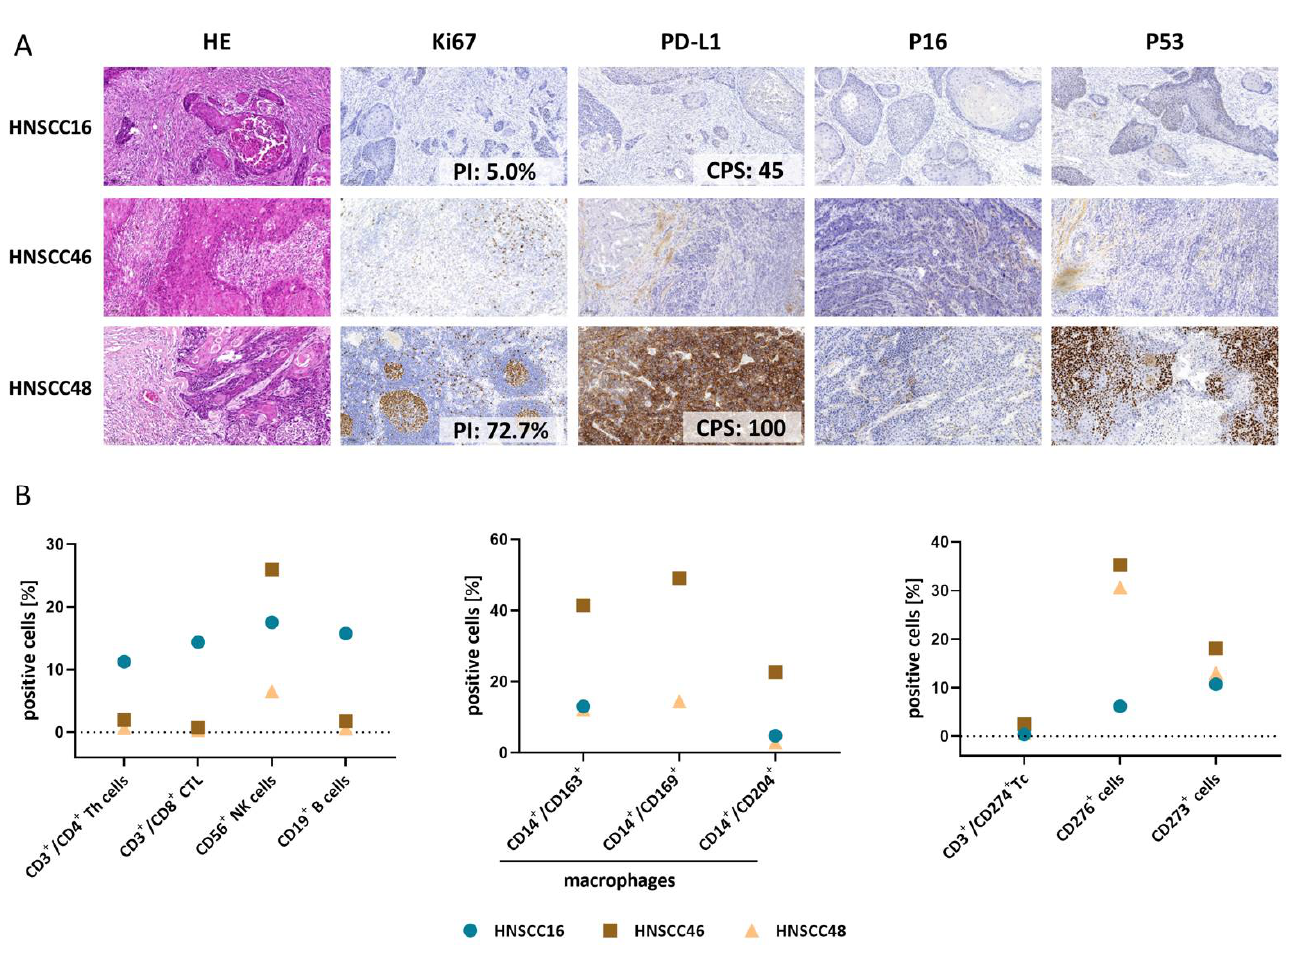
Figure 1. Histopathology and tumor microenvironment of primary tumors. ( A ) HE-, Ki67-, PD-L1, P16-, and P53-staining of the patients’ tumors HNSCC16, HNSCC46, and HNSCC48. 10 × magnification. ( B ) Tumor microenvironment of the primary tumors HNSCC16 (turquoise circles), HNSCC46 (brown squares), and HNSCC48 (orange triangles). Relative fractions of lymphocytes (left diagram), TAMs (middle diagram), and selected checkpoints (right diagram) are illustrated.